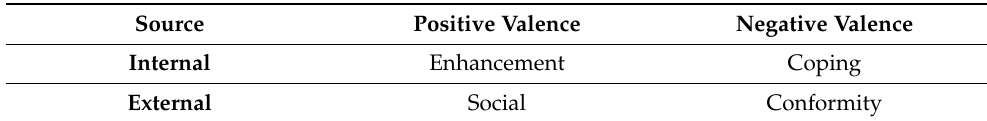
Table 1. Classification of motives for SNSs use based on the motivational model for problematic behaviors. Source Positive Valence Negative Valence Internal Enhancement Coping External Social